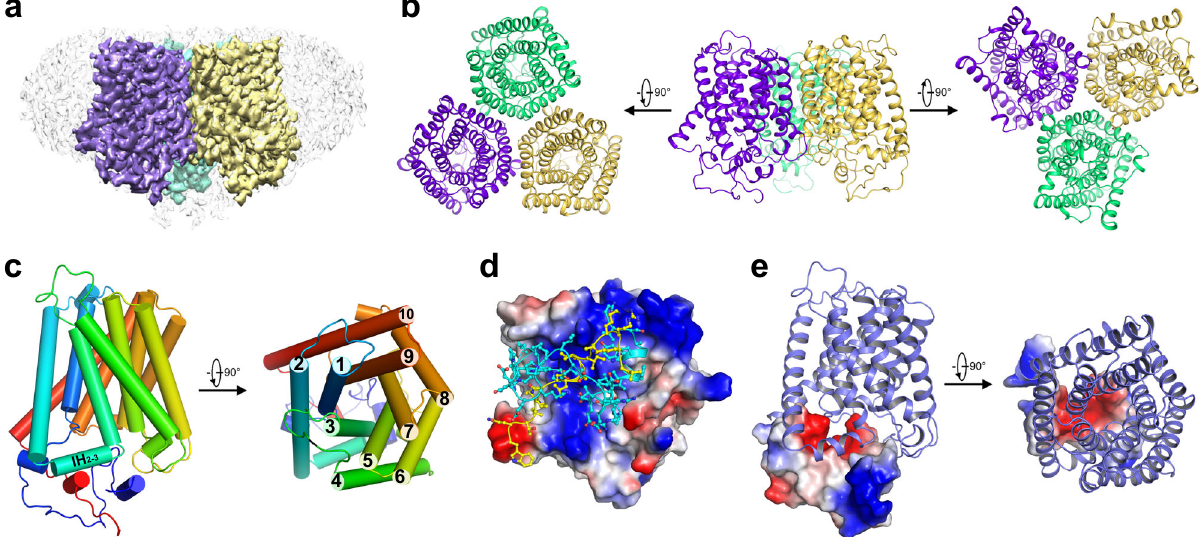
Fig. 2 Structure determination of the At SLAC1 S59A mutant. a A side view of the EM density for the At SLAC1 S59A mutant at 2.7 Å resolution. Densities corresponding to the three subunits are color-coded, and the surrounding micelle is shown in light gray. The density maps are generated by Chimera 39 . b Three different views are presented here for the structure model of At SLAC1 S59A mutant. c Overview of the subunit structure of At SLAC1 S59A mutant. The ten transmembrane segments (TMs) are organized in two layers, with the inner layer forming the anion conducting pore. TM2 and TM3 is linked by a short juxtamembrane helix, named IH 2 – 3 . d The surface electrostatic potential of the transmembrane domain of At SLAC1 viewed from the cytoplasmic side. The N- and C-terminus of At SLAC1 are shown in sticks, colored cyan and yellow, respectively. e The surface electrostatic potential of the cytosolic domain of At SLAC1 shown in a side view (left) and top view from the extracellular side (right). The electrostatic potential is highly negative near the pore for the cytosolic domain, and complements to the positive potential of the transmembrane domain in this